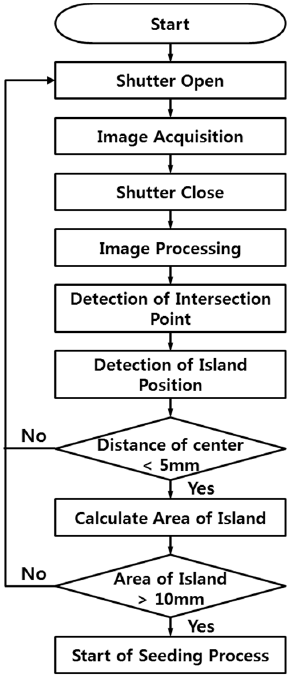
Figure 9. Flowchart of the auto-seeding process.